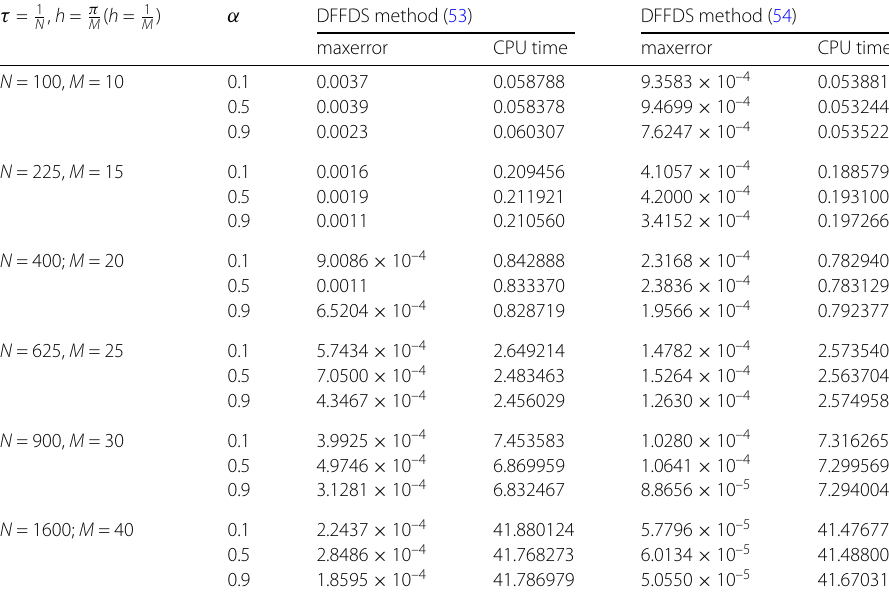
Table 2 Second error